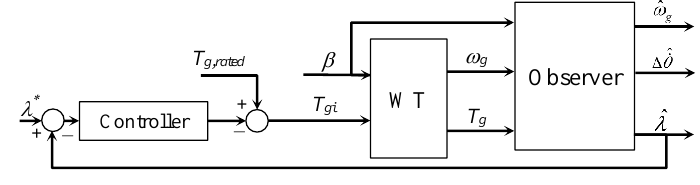
Figure 4. Tip-speed ratio control based on the observer.